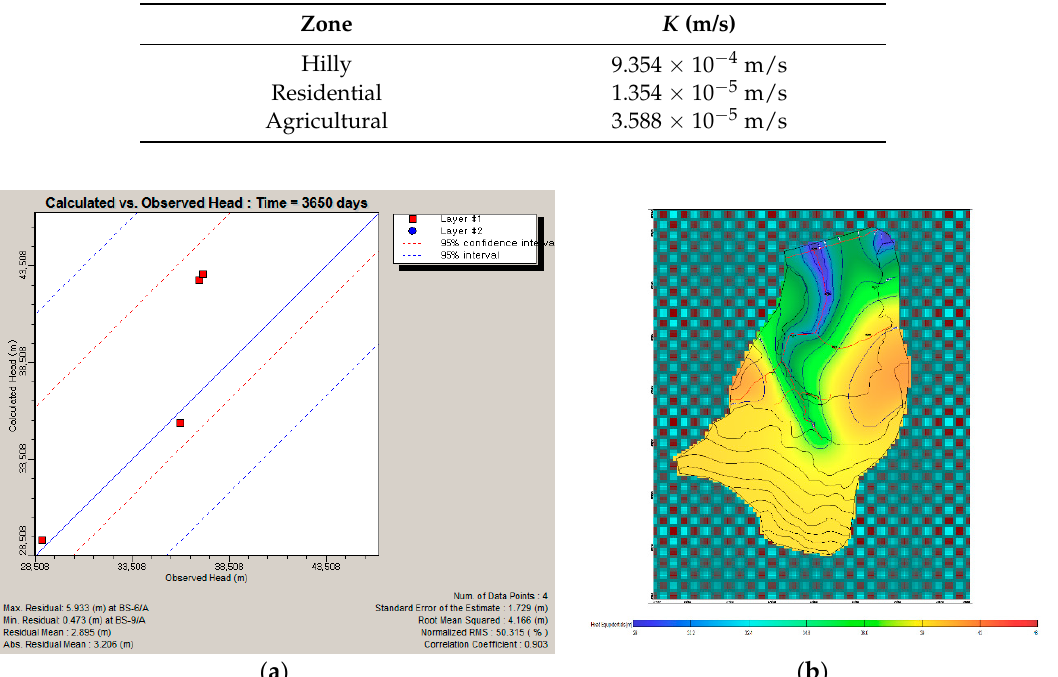
Table 12. The hydraulic conductivity values from the steady-state model’s calibration.